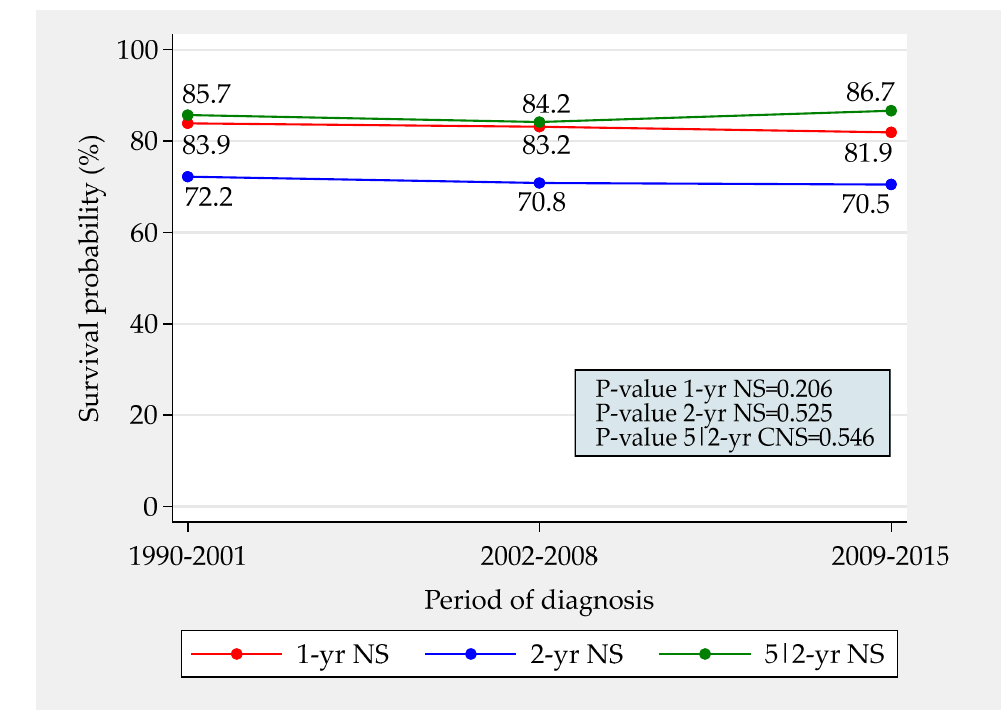
Figure 2. Trends in total 1- and 2-year net survival and in 5|2-year conditional net survival from vulvar squamous cell carcinoma in Italy between 1990 and 2015 (total resident female population 15,358,161 in 2015).